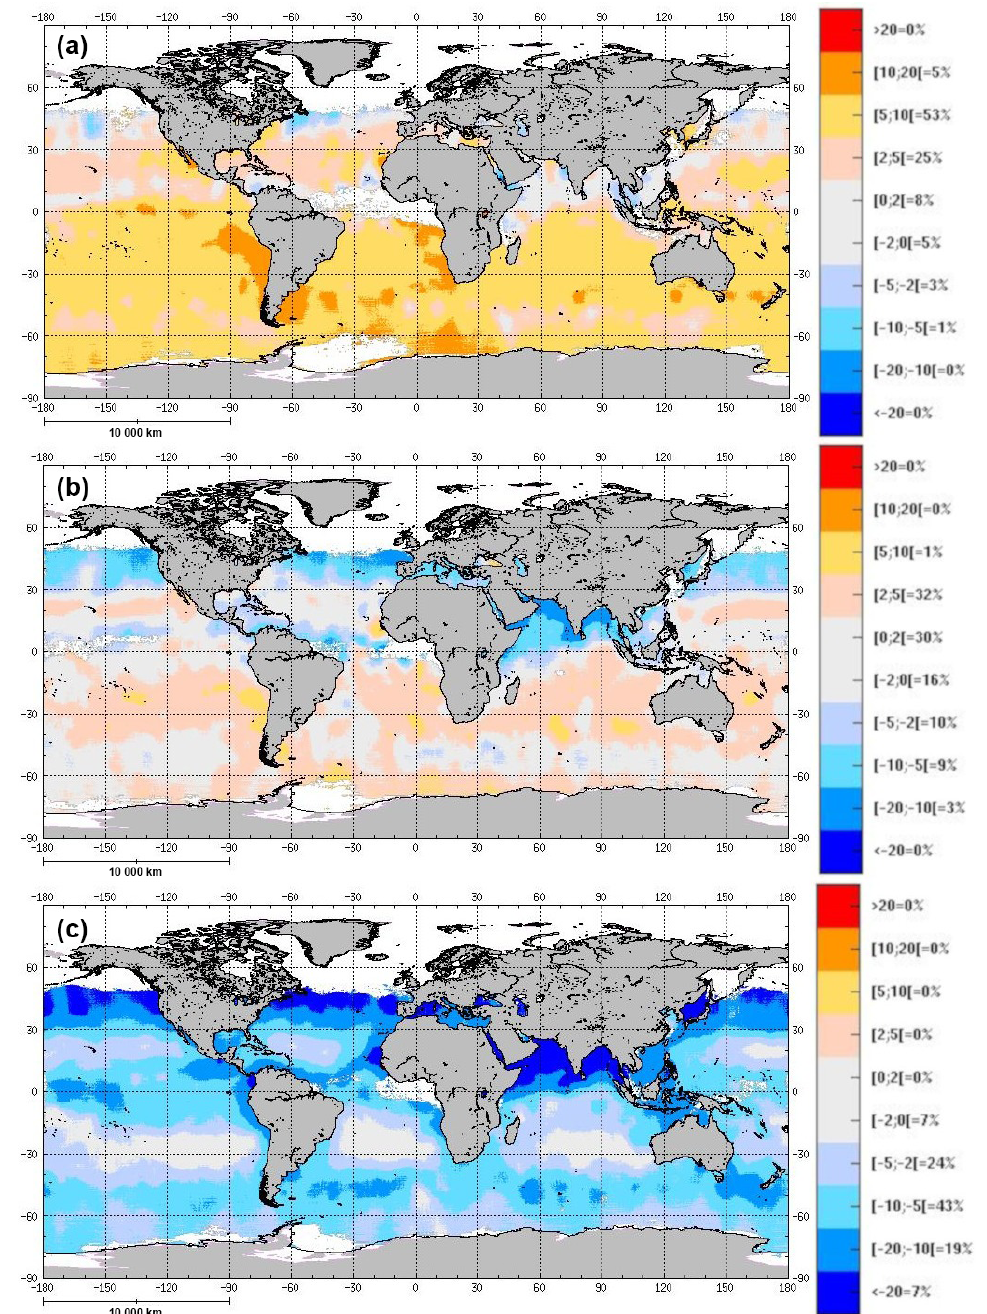
Figure 4. Relative difference of VIIRS and MODIS at Rrs(443) (in percent) based on the monthly NASA R2018 global products at 4km. VIIRS has suffered from a significant trend since its launch, as illustrated by the January monthly evolution for the years (a) 2012, (b) 2016 and (c)